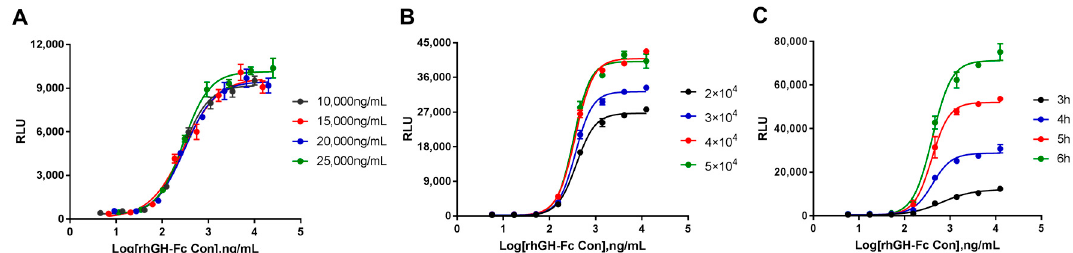
Figure 2. Optimization of experimental parameters of the bioassay. ( A ) Final working concentration of rhGH-Fc. ( B ) Cell numbers per well. ( C ). Incubation time with HEK293-Luc cells and rhGH-Fc.